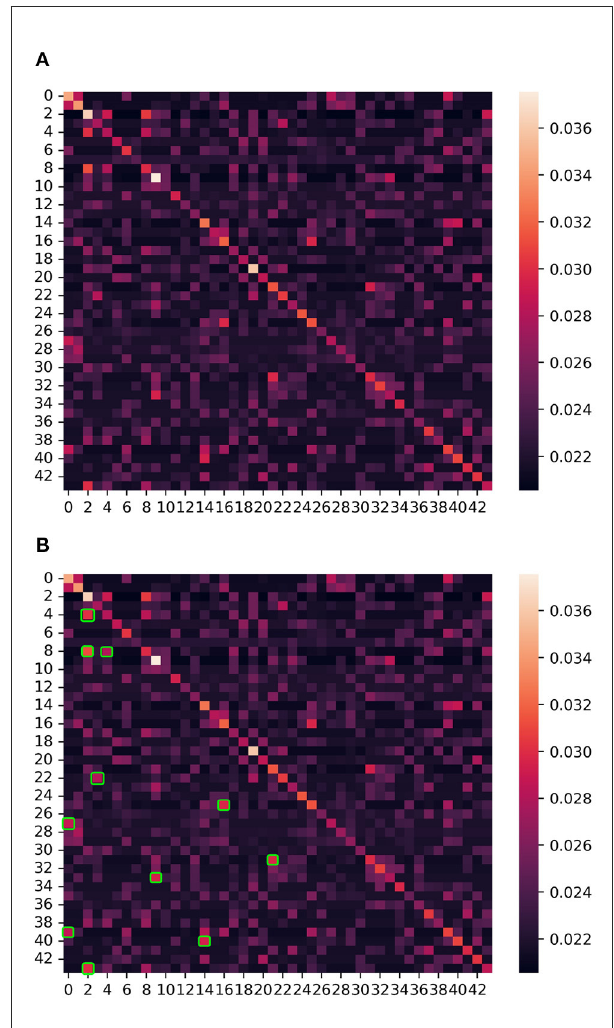
FIGURE4 The heat map of the graph adjacency matrix of the entire brain region (i.e., 44 channels). The numbers 0–43 on the left and below represent channels 1–44, and one channel corresponds to one node of the graph. Each small square on the figure represents the correlation (i.e., edge) between channels, and the color of the square represents the degree of correlation between channels (i.e., weight on the edge). The correlation measurement standard is shown in the color axis and number axis on the right. The brighter the color and the larger the value, the stronger the correlation between two channels (nodes). In addition, the main diagonal represents the autocorrelation of these channels (nodes), and the regional correlations on both sides of the main diagonal are completely symmetrical. (A) The heat map of the entire brain region. (B) The strong correlation (bright areas) regions are marked with green